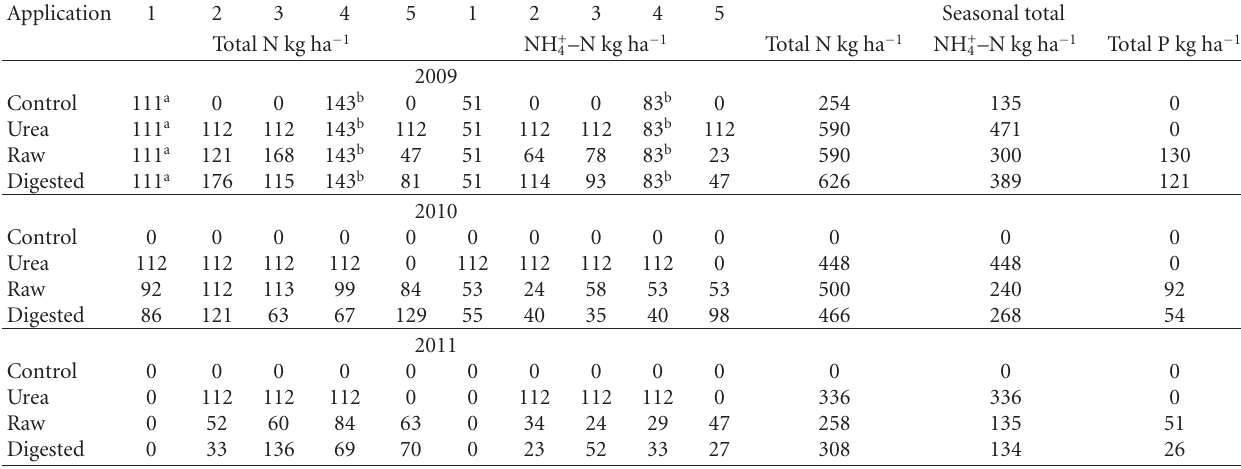
Table 4: Application rate of fertilizer source at each application period, and seasonal total N and P inputs,